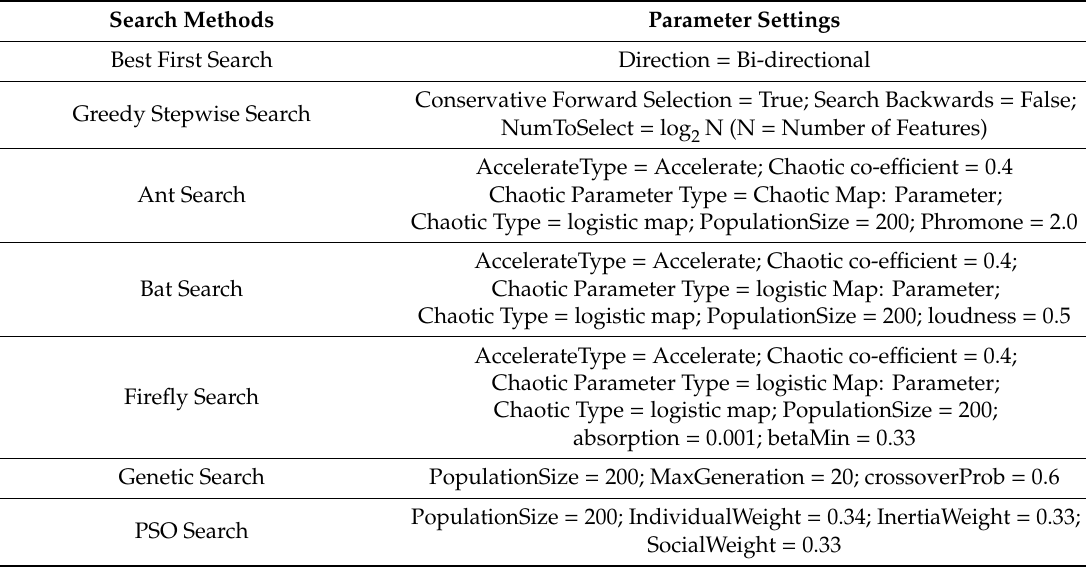
Table 3. Various Search Methods and Parameter